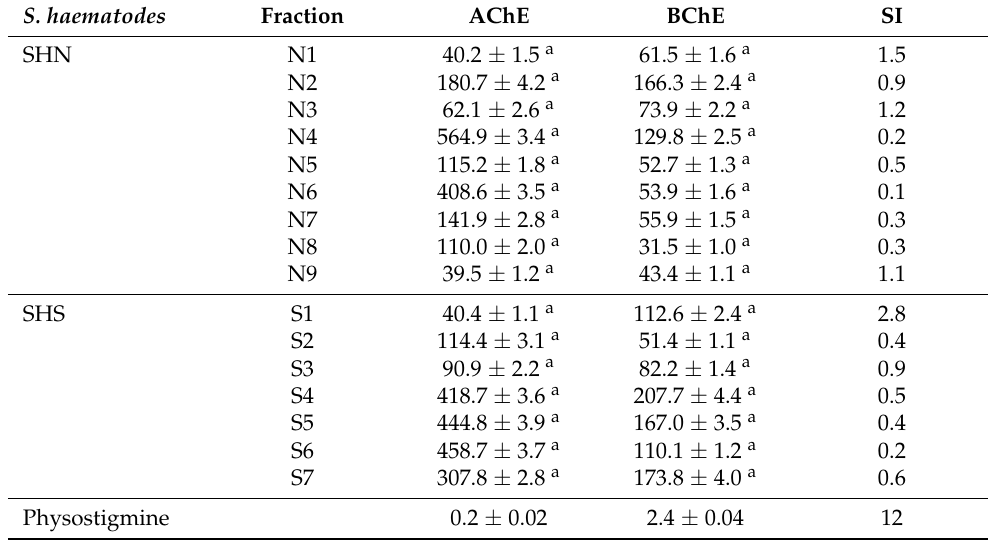
Table 5. AChE and BChE inhibitory activity (IC 50 , µ g/mL) of S. haematodes SHN and SHS fractions. S.